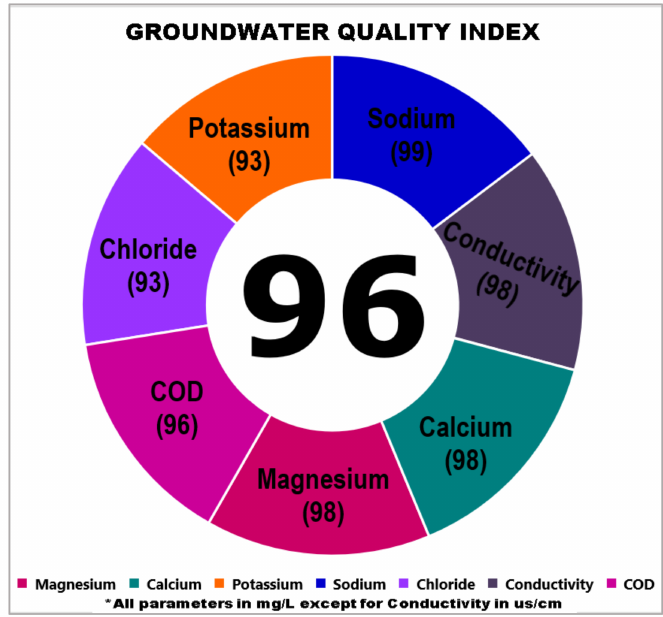
Figure 5. GWQI in Kelantan agricultural